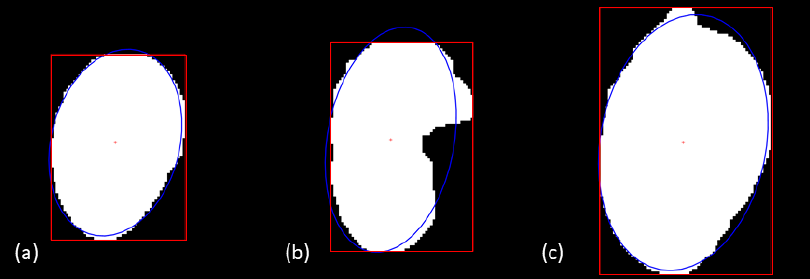
Figure 2. Ellipse fitting: ( a ) An identified well-separated fruit with (cid:101) = 0.65 and r = 0.99; ( b ) failure to fit an ellipse as r = 0.93; ( c ) failure to fit an ellipse as bounding box (red) length is 4 pixels greater than ellipse (blue) major axis.